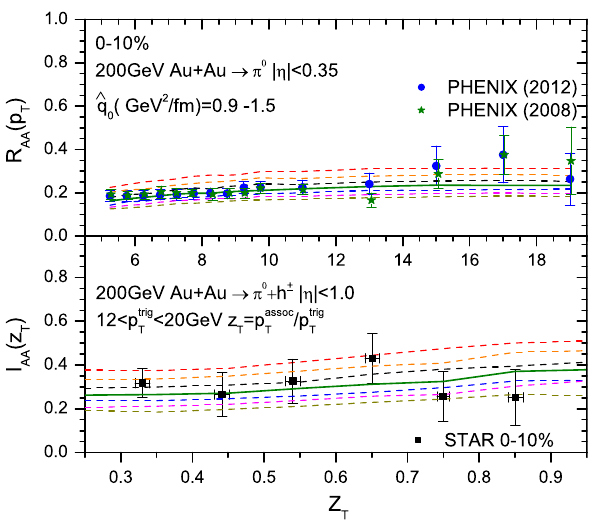
Fig. 1 The single hadron and dihadron suppression factors in central √ s NN = 0 . 2TeVcomparedwithPHENIX 0–10%Au+Aucollisionsat